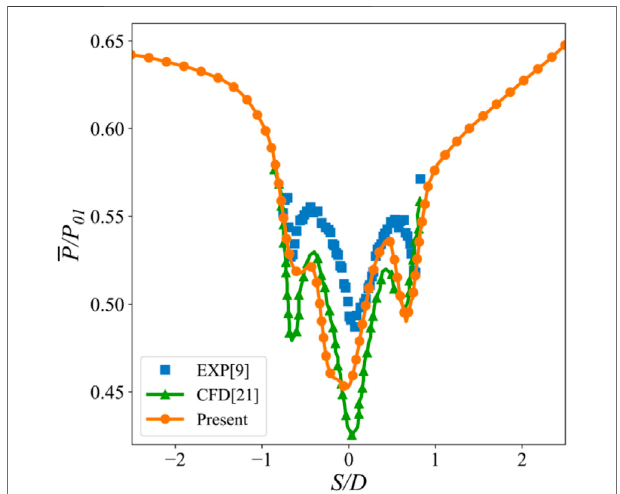
FIGURE 7 | Time-averaged pressure distribution at the trailing edge.